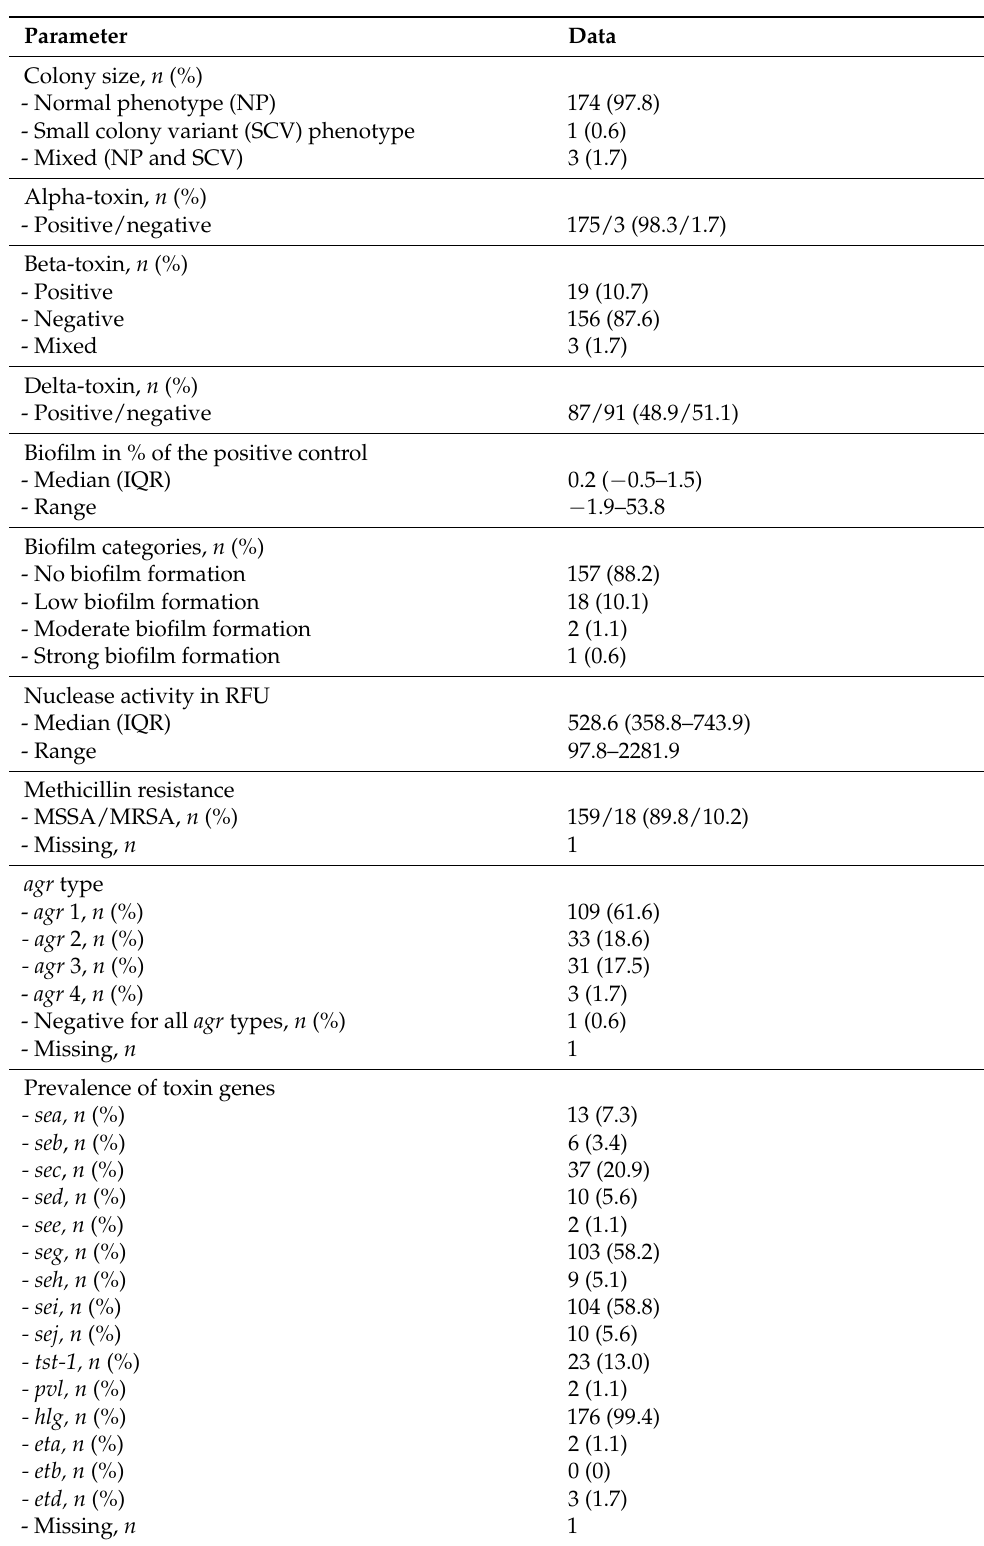
Table 3. Isolate